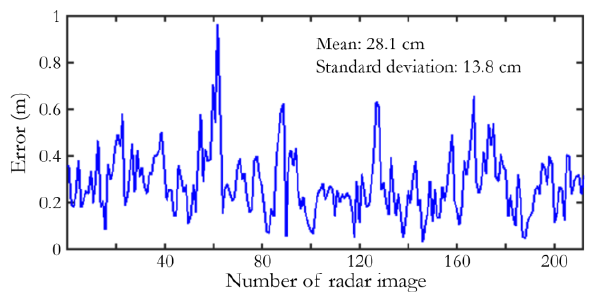
Figure 10. Positioning error. The computed error is the Euclidean distance between corresponding GPS and radar